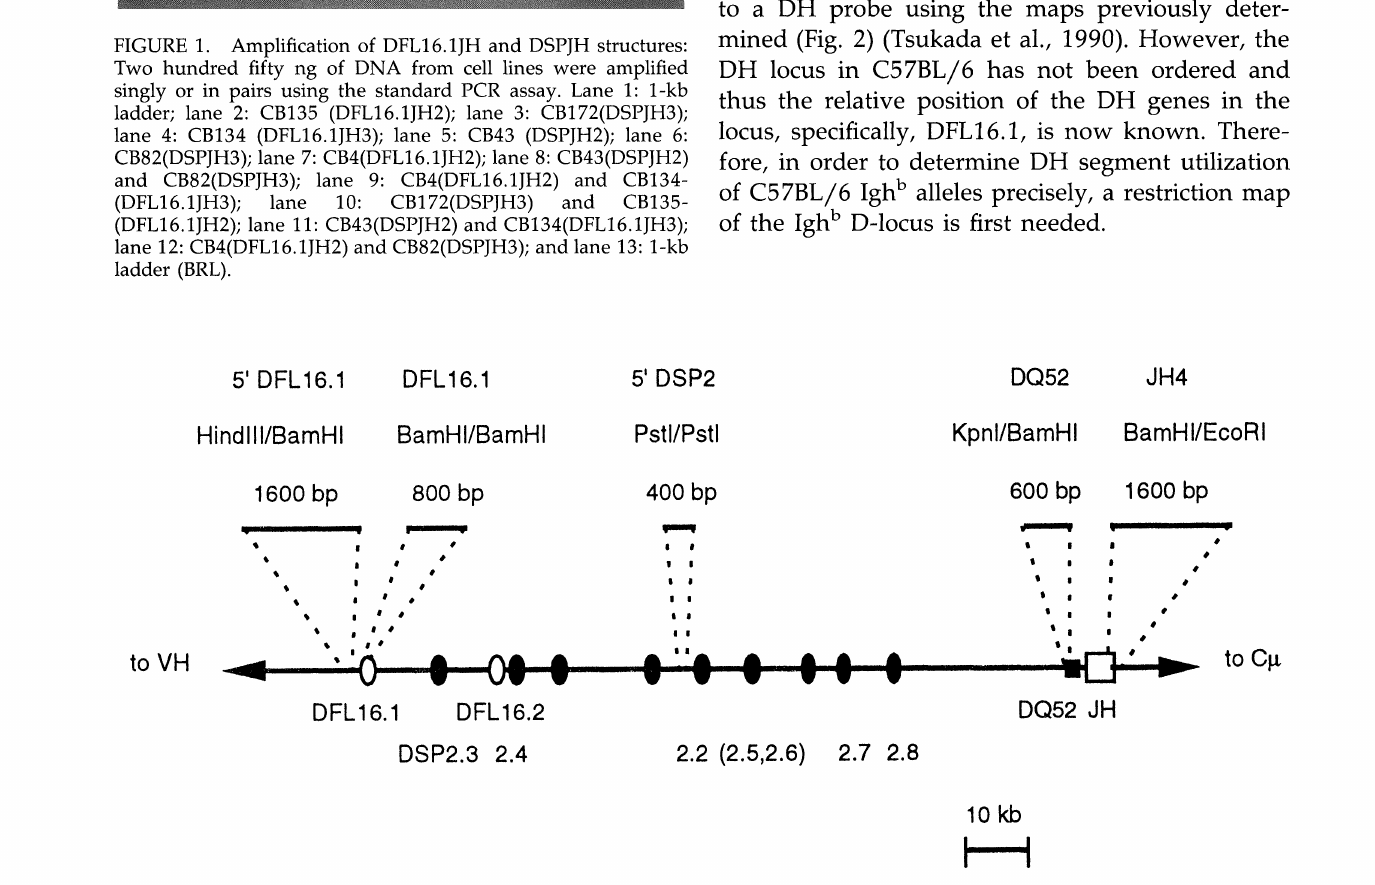
FIGURE 2. D locus in BALB/c: The map of the D region is based on mapping data from Kurosawa and Tonegawa (1982) and Tsukada et al. (1990). The closed box represents DQ52, closed ovals represent DSP family members, and open ovals represent DFL16 family members. The open box indicates the JH region. The probes used in this study, their flanking-restriction endonuclease sites, and their sizes are indicated above the solid bars. The dotted lines indicate the relative position the fragment occupies in the BALB/c